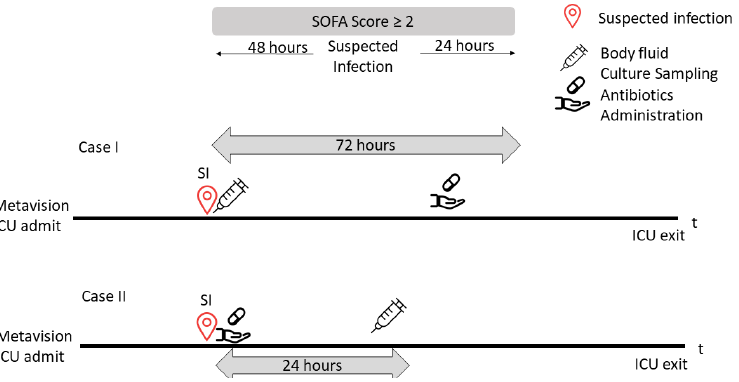
Figure 4. Sepsis-3 suspected infection